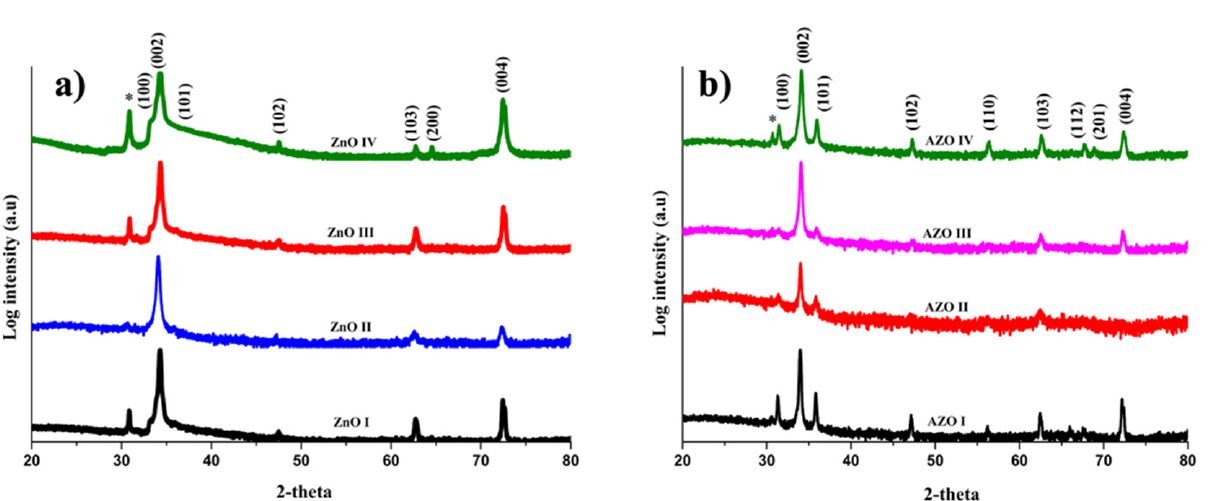
Figure 1. XRD pattern for: ( a ) ZnO and ( b ) AZO NRs grown at various pH. Peak (*) corresponds to Zn(OH) 2 phase. Table 2. Crystalline properties of ZnO and AZO samples from XRD analysis.